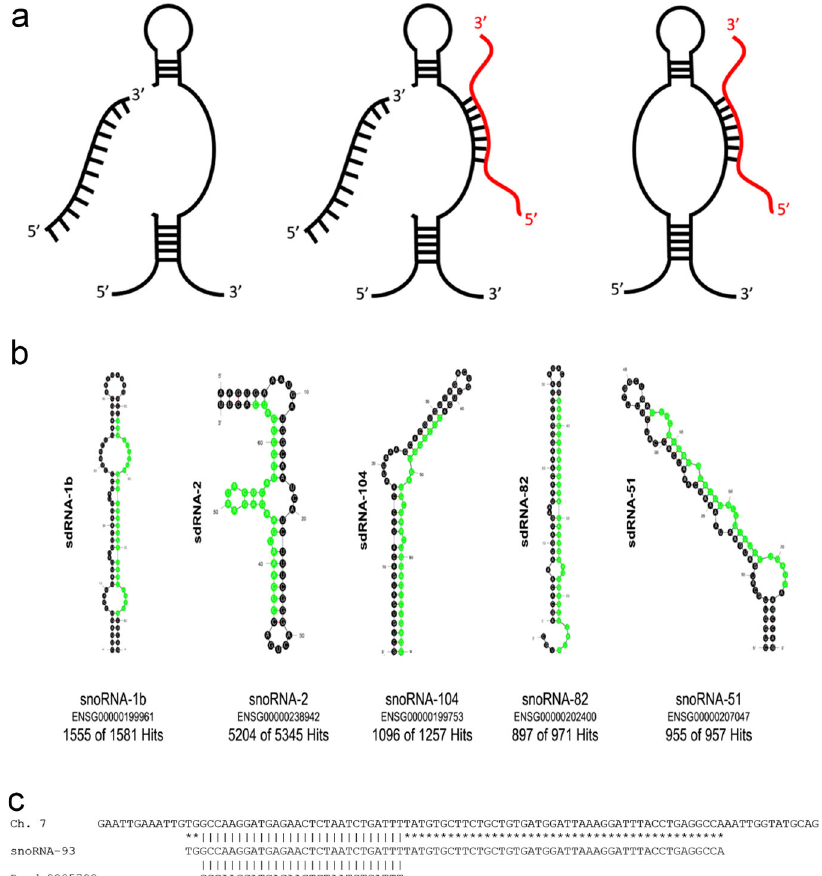
Fig. 1 SdRNAs are speci fi cally processed from annotated snoRNA loci. a Transcripts arising from various annotated snoRNA loci have now been de fi nitively shown to participate in at least two distinct noncoding RNA regulatory pathways. Individual loci can produce snoRNAs functioning exclusively as either a traditional RNA editor ( right ) or as a functional miRNA precursor ( left ) while some loci have now been con fi rmed to produce transcripts at times engaging in both types of noncoding RNA regulation ( center ) (reviewed in ref. 5). MiRNA-like excision products are illustrated in black ( left and center ) as excision products of primary transcript. Complementary RNA editing targets are shown in red ( right and center ). b The most thermodynamically stable secondary structures of putative sdRNA producing snoRNAs with sdRNA sequences highlighted in green as calculated by Mfold. 53 Common name and Ensembl gene id for putatively processed snoRNAs are listed below corresponding structures. “ Hits ” refer to the number of times fragments of putative sdRNA producing snoRNAs perfectly aligned to small RNA-seq reads from individual SRA datasets. Numbers preceding total numbers of hits correspond to the number of times positions highlighted in green (putative sdRNAs) perfectly aligned to small RNA-seq reads (e.g., 1555 of 1581 small RNA reads aligning to snoRNA-1b corresponded to the sequence highlighted in green ). c Alignment between the human genome (GRCh38:7:22856601:22856699:1) ( top ), snoRNA-93 (ENSG00000221740) ( middle ), and next generation small RNA sequence read ( bottom ) obtained by Illumina sequencing of MDA- MB-231 RNA is shown. All sequences are in the 5 ′ to 3 ′ direction. An asterisk indicates base identity between the snoRNA and genome. Vertical lines indicate identity across all three